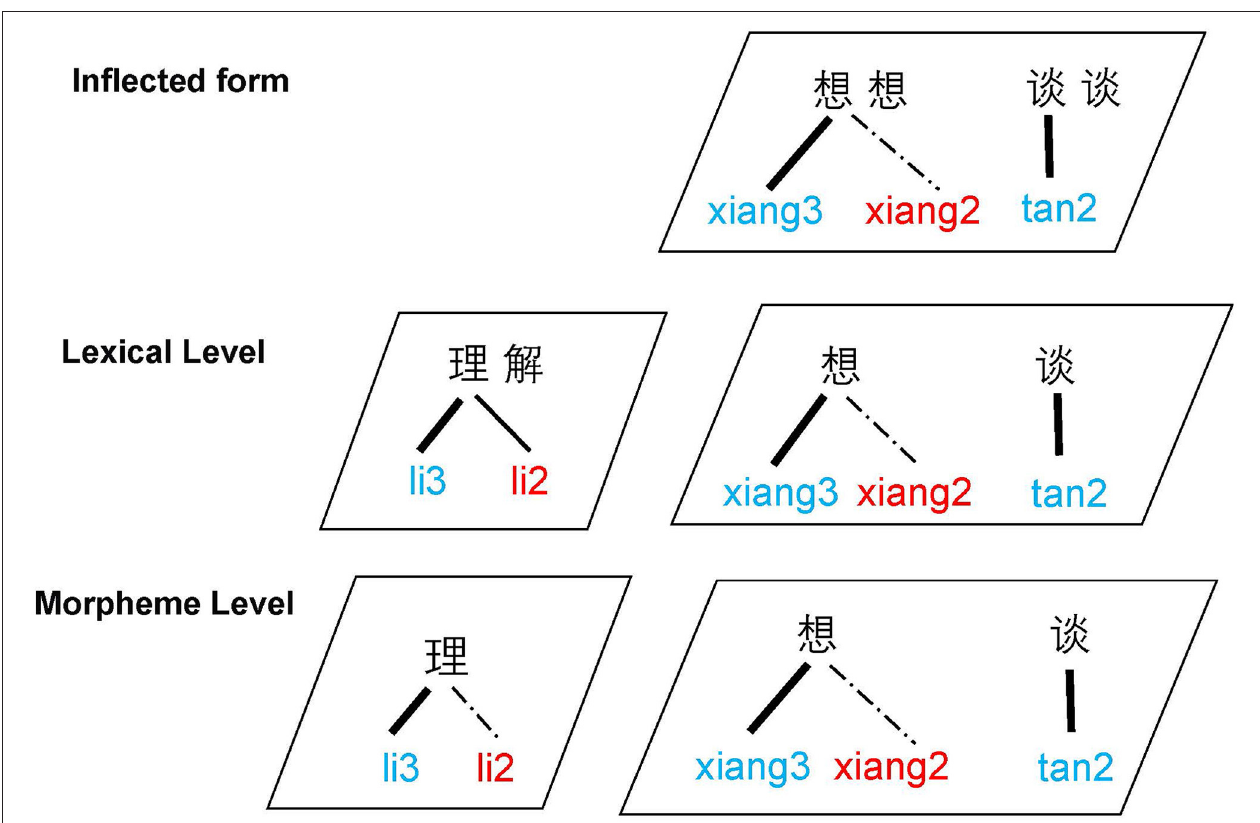
FIGURE 6 | Multi-level representation model for tonal